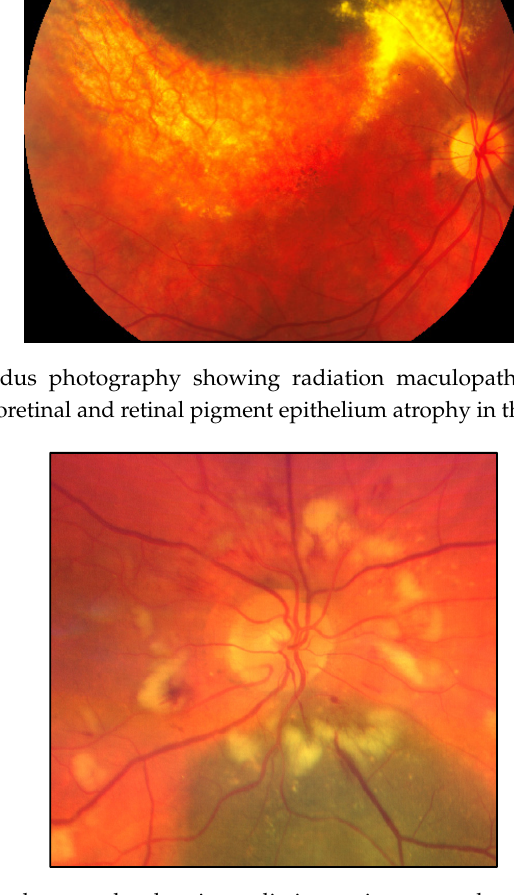
Figure 3. Color fundus photography showing radiation optic neuropathy, characterized by optic disc edema, peripapillary hemorrhages and peripapillary exudates. The treated uveal melanoma is visible as a pigmented lesion inferior to the optic nerve.